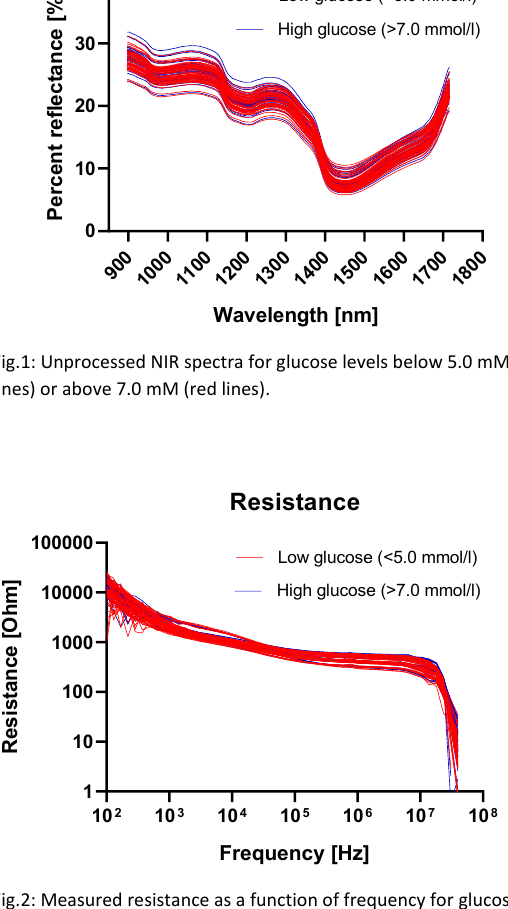
Fig.2: Measured resistance as a function of frequency for glucose levels below 5.0 mM (blue lines) or above 7.0 mM (red lines).